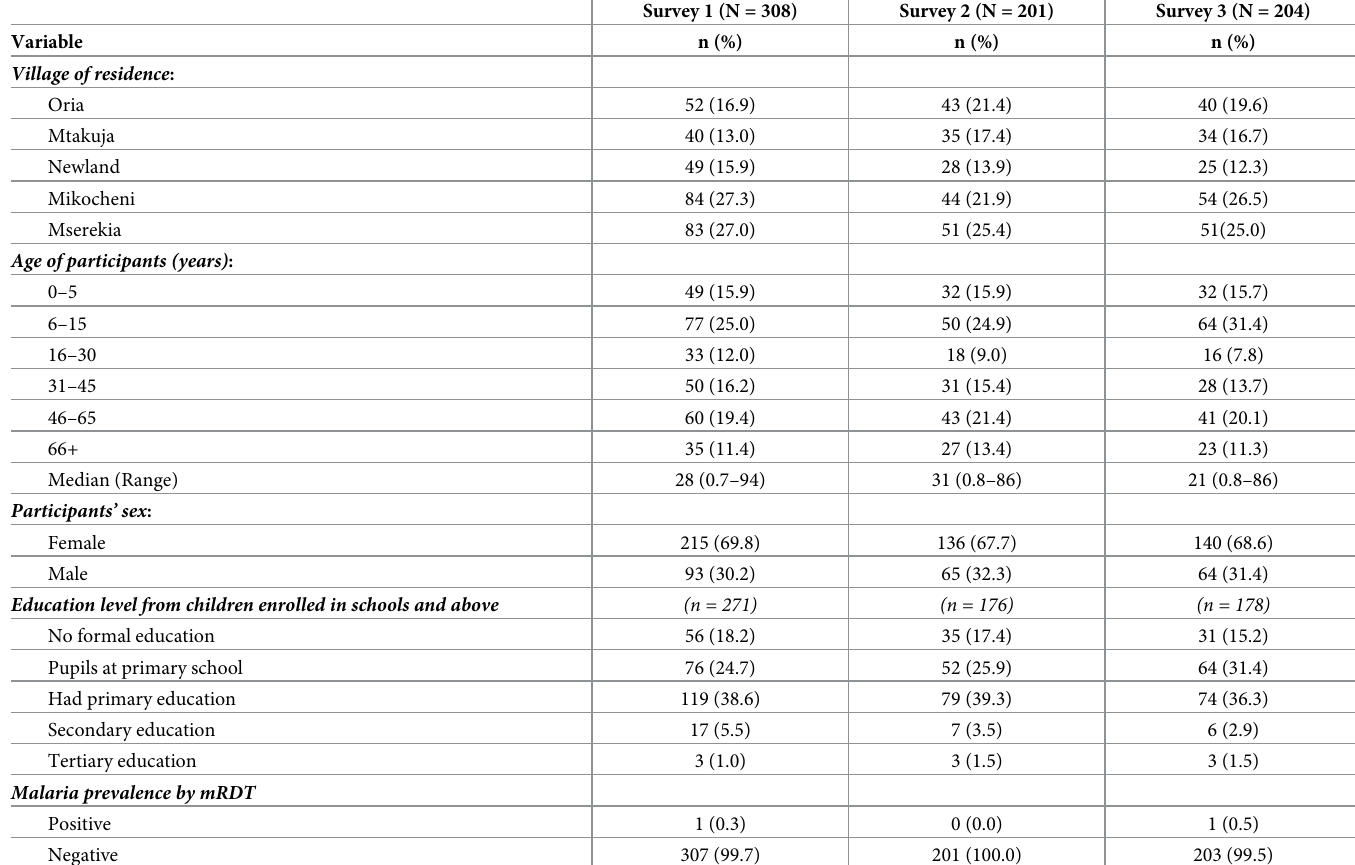
Table 1. Socio-demographic characteristics of the study population and malaria positivity by survey: N = 308. Survey 1 (N = 308) Survey 2 (N = 201) Survey 3 (N =